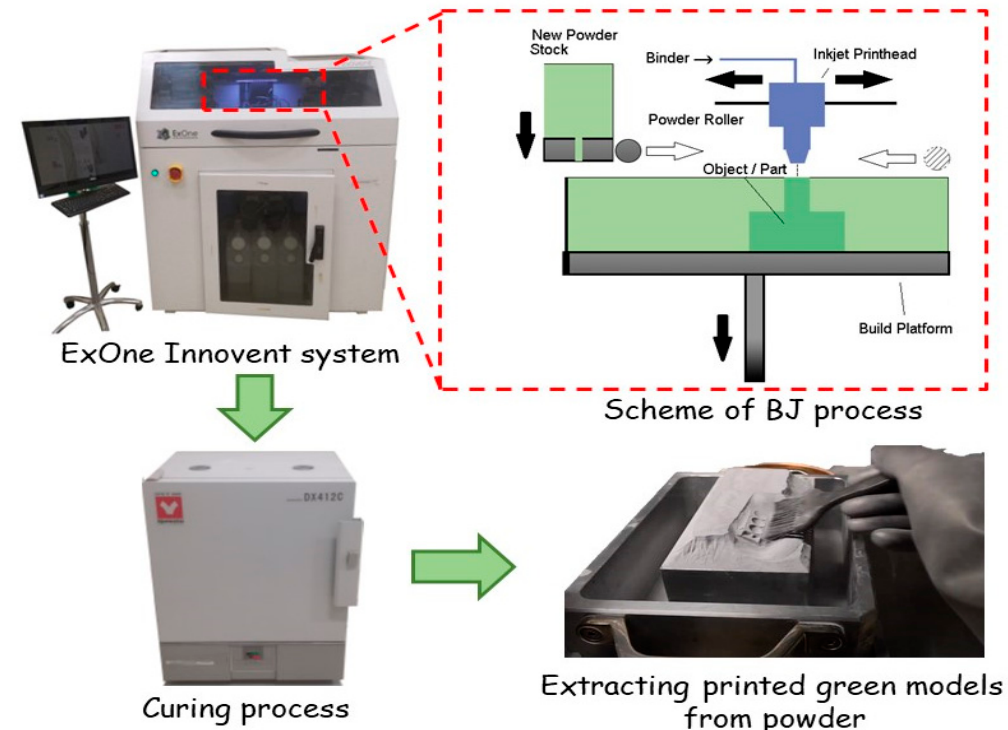
Figure 4. Process flow for BJ additive manufacturing.